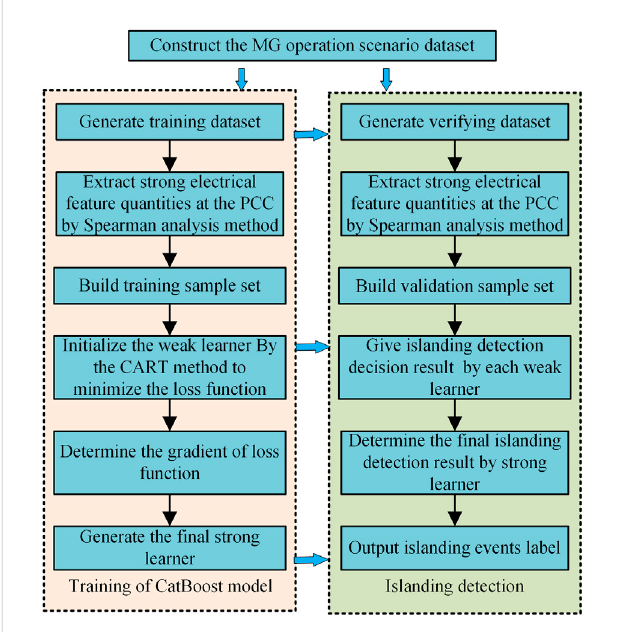
FIGURE 2 Flow chart of the proposed islanding detection method.